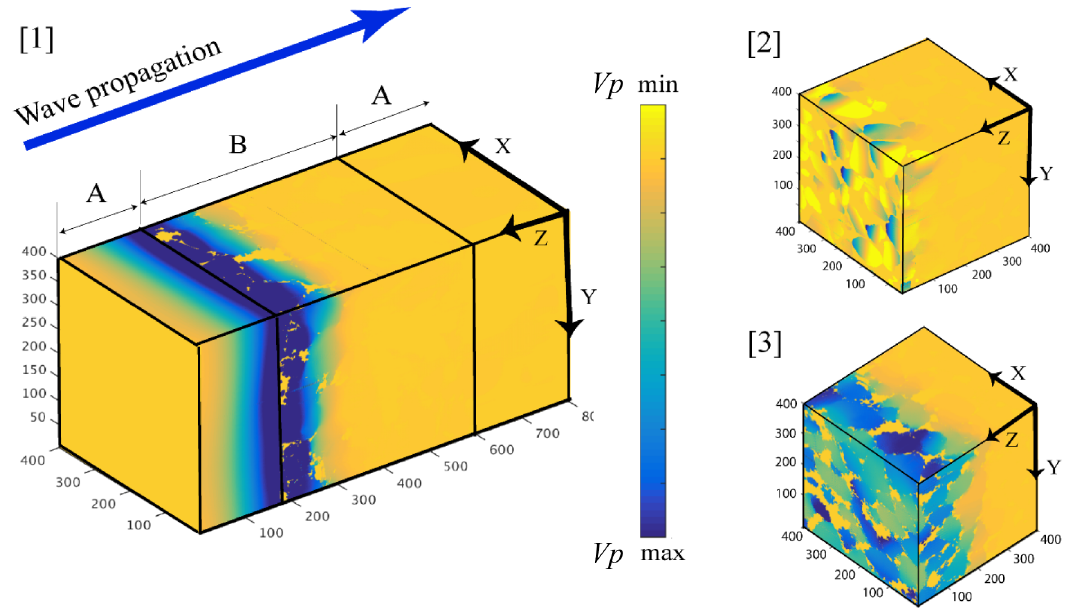
Figure 13. (1) Visualization of the RSG model where A is a predefined homogenous solid in which the 400 × 400 × 400 size volume is em- bedded. The plane wave propagates in z direction. (2) Visualization of the V p in a sample containing roughly 7% of hydrate. (3) Visualization of the V p in a sample bearing 17% of hydrate where the V p is significantly higher due to the increased hydrate bulk.